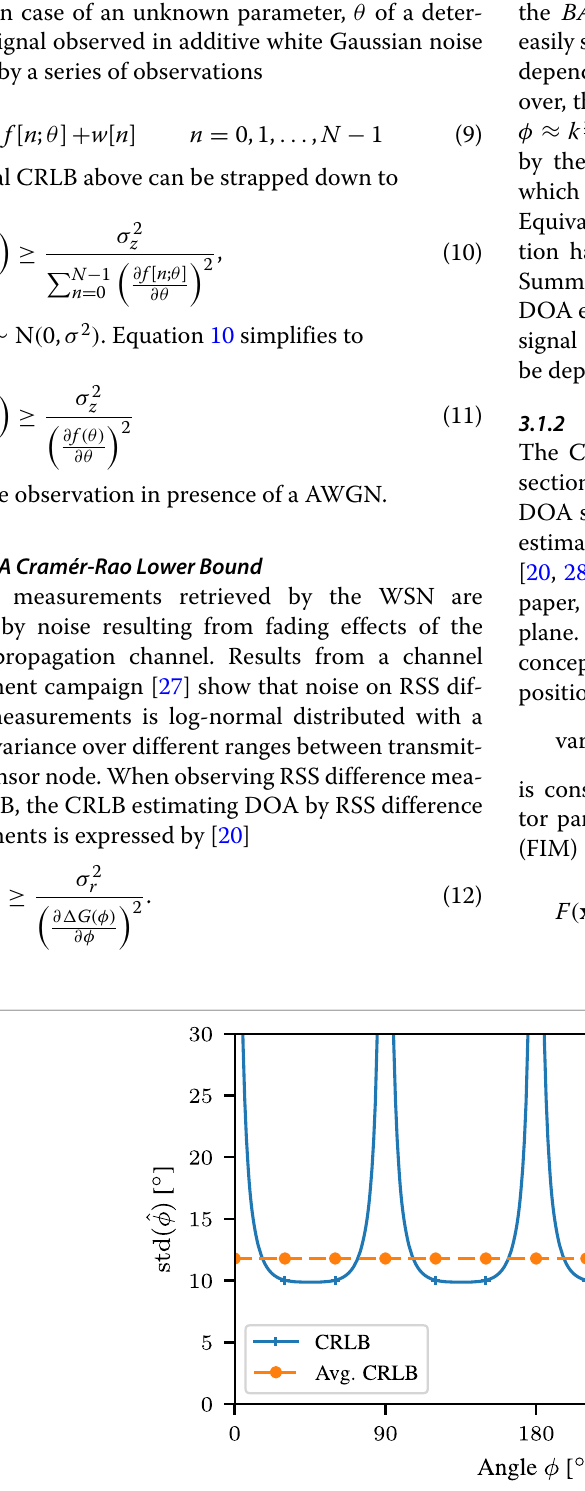
Fig. 3 CRLB for RSS-based DOA estimation. Apparently, DOA estimation variance depends on the direction of the received signal. For a received , the variance approaches infinity. This is quite obvious, as the gain difference function (cid:6) G (φ) is close to zero in that signal direction of φ ≈ k π 2 range. Therefore, network topologies, especially node orientation,